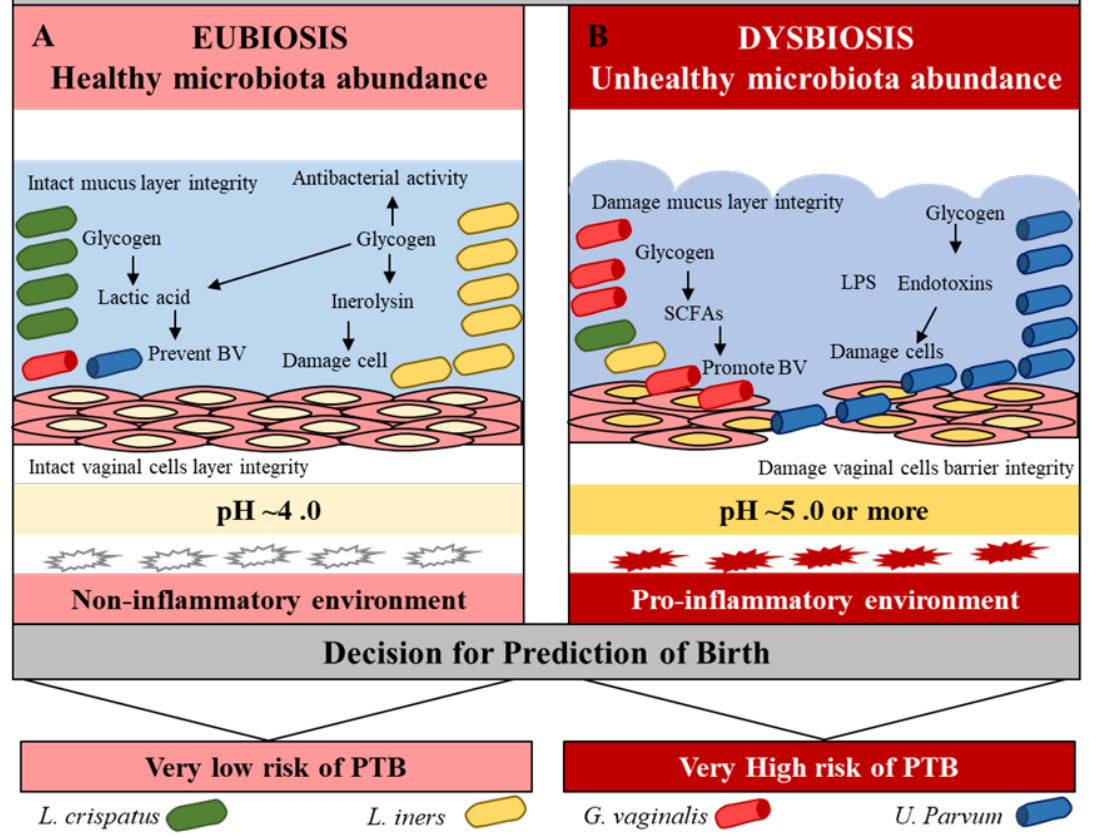
Figure 2. Vaginal microbiota eubiosis and dysbiosis. Effect of beneficial and pathogenic microbiota in the vaginal environment. Pink = normal, while red = inflammation conditions. Table 1. Microbial richness in preterm birth.